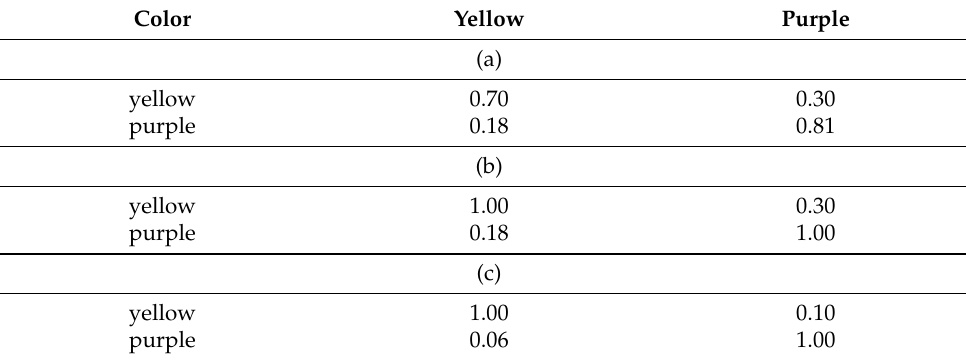
Table 3. An example application of the second step of per-attribute learning-based